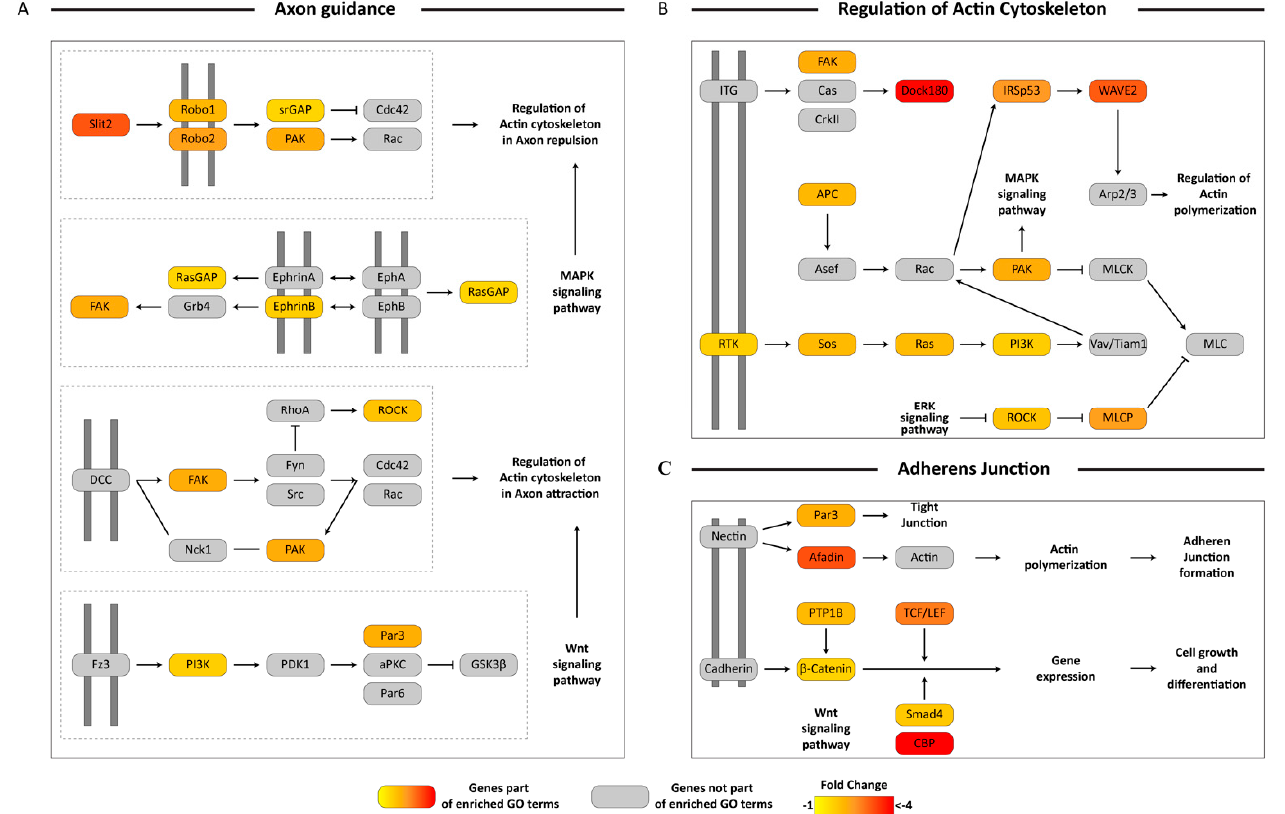
Figure 3. Pathway visualization using downregulated di ff erentially-expressed unigenes in Axon guidance, Regulation of actin cytoskeleton and Adherens junction. Transcripts from enriched Gene Ontology (GO) terms from the downregulated unigene set were mapped on to KEGG Axon guidance pathway ( A ), Regulation of actin cytoskeleton ( B ) and Adherens junction ( C ) pathways and visualized manually. Boxes in color represent protein coding genes that were present within the enriched GO terms. The gradient of the color represents their fold change. Grey boxes represent protein coding genes not present in the enriched GO terms. Dotted lines represent individual modules within the parent pathway. Pathway components present on double grey lines represent cell membrane receptors. Log 2 FC di ff erences between the two conditions can be referenced in Table S2.